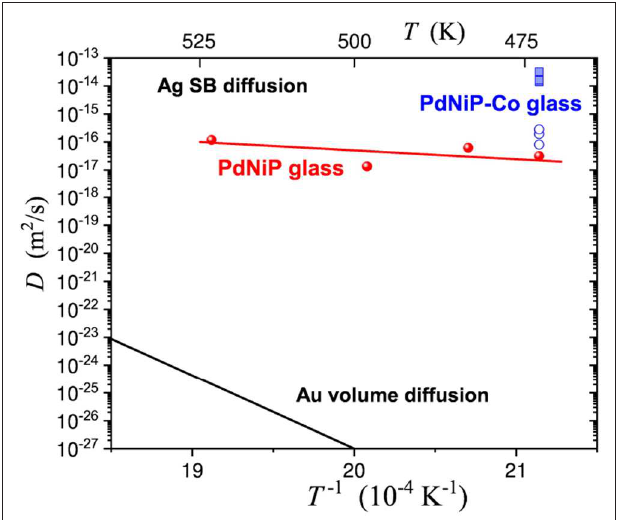
FIGURE 6 | Arrhenius plot for Ag diffusion along shear bands (red symbols Binkowski et al., 2016) in comparison to the extrapolation of the Arrhenius dependence measured for Au bulk diffusion (Duine et al., 1993) in PdNiP glass of nominally the same composition (black line). For comparison, the shear band diffusion coefficients measured for Ag diffusion in cold-rolled PdNiP-Co glass (Hubek et al., 2020) are shown (blue symbols).